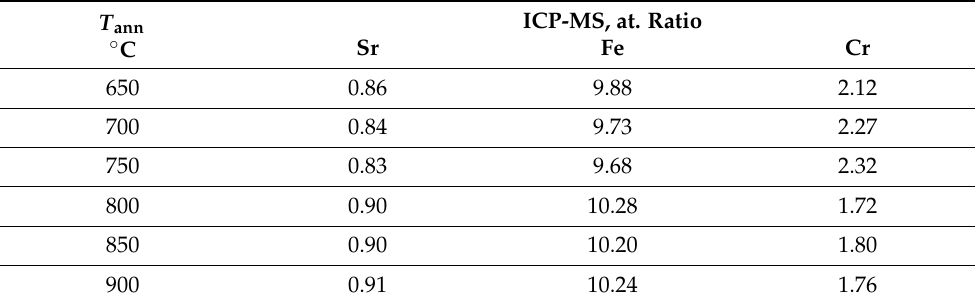
Table 2. Chemical analysis of hexaferrite particles’ composition 1 . T ann ◦